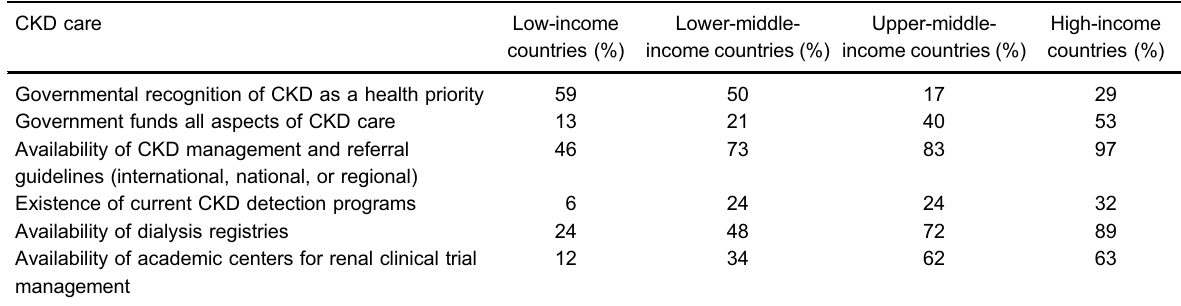
Table 1. World Bank country group for chronic kidney disease